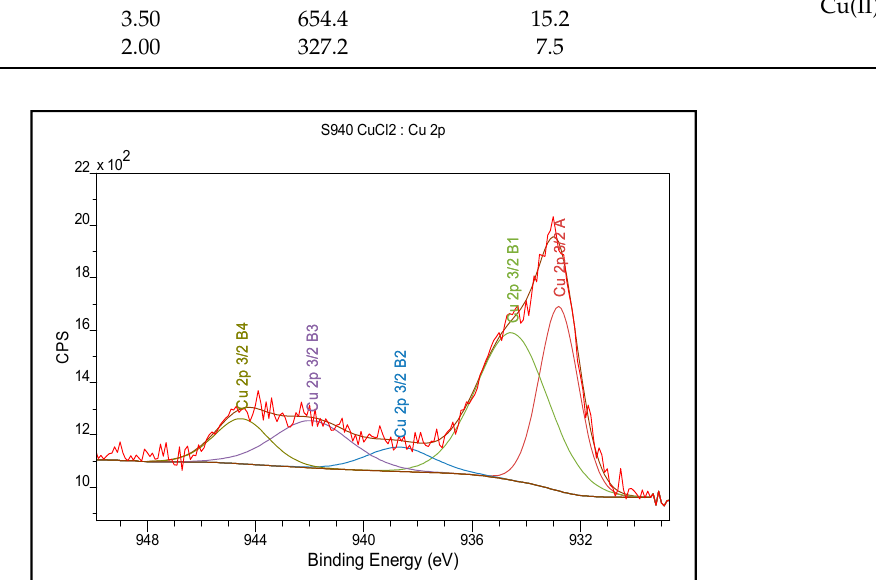
Figure 11. The XPS spectrum obtained in the narrow range of binding energy for Purolite S 940 after the Cu(II) ion sorption process. Table 8. The Elemental composition determined for the Purolite S 950 after the Cu(II) ion sorption process.